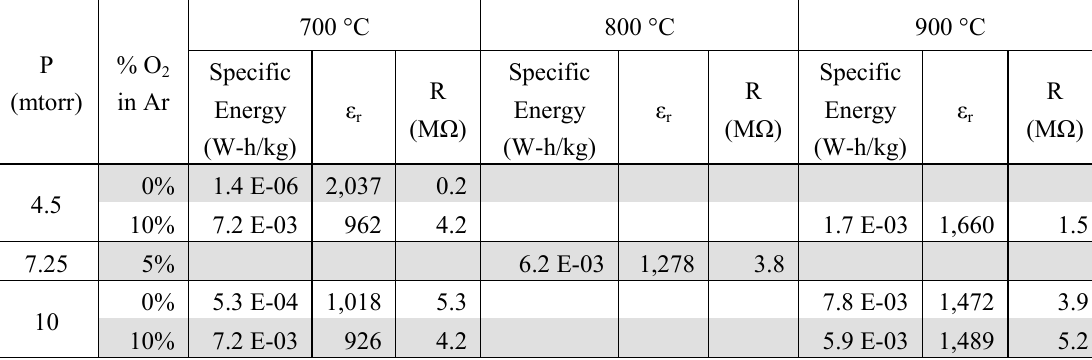
Table 1. Specific Energy (from DC load/ unload data), relative permittivity and resistivity (from low frequency, small signal capacitance) vs . deposition conditions for thin-film capacitors with sputtered BCZTO